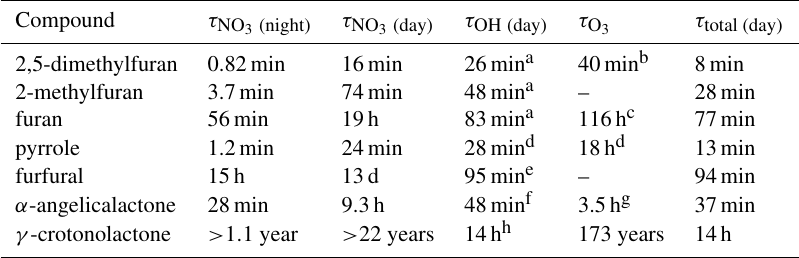
Table 5. Atmospheric gas-phase lifetimes of the compounds reported herein based on typical midday OH concentrations of 5 × 10 6 molec.cm − 3 , night-time NO 3 concentrations of 2 × 10 8 molec.cm − 3 , daytime NO 3 concentrations of 1 × 10 7 molec.cm − 3 ,